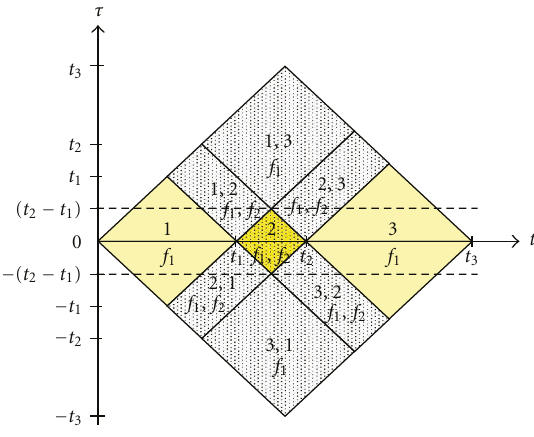
Figure 2: Bilinear product of the transient